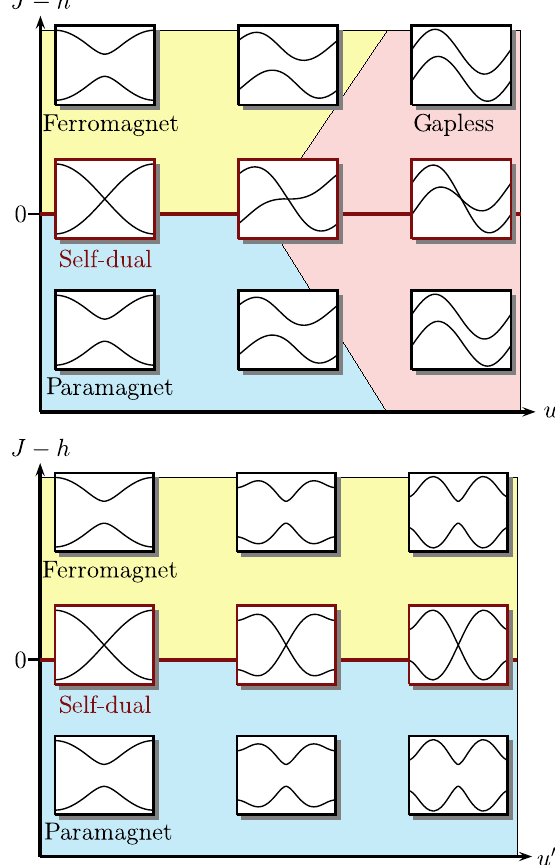
FIG. 9. Energy spectra of the perturbed Ising models H 0 þ δ H and H 0 þ δ H 0 . The former preserves T and is gapless along the self-dual line J ¼ h . For small u , this line separates gapped paramagnetic and ferromagnetic phases. In contrast, for large u , the system enters an extended gapless phase with central charge 1, and self-duality is not required for the gaplessness. The model H 0 þ δ H 0 preserves T 0 and is gapless only at